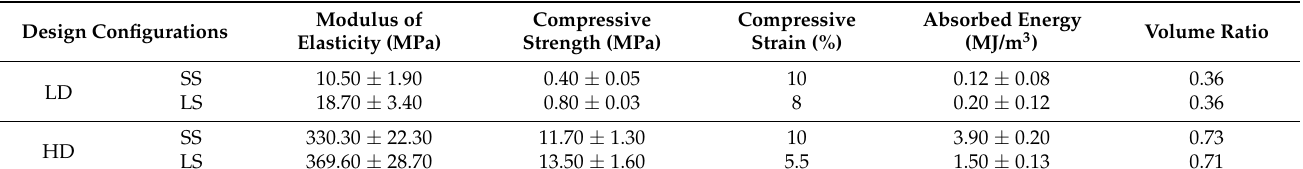
Table 1. The results for the average mechanical properties of boundary lattice structure designs. Design Configurations